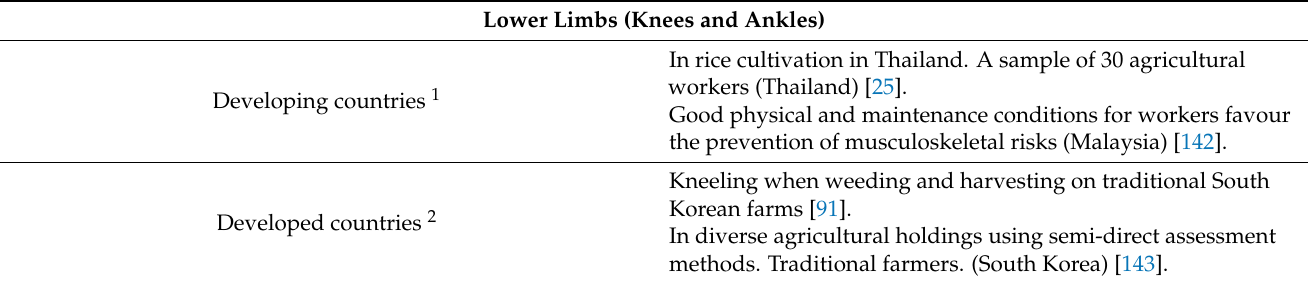
Table A6. MSD research in agriculture (1995–2020). Category: Lower limbs (knees and ankles). Lower Limbs (Knees and Ankles)